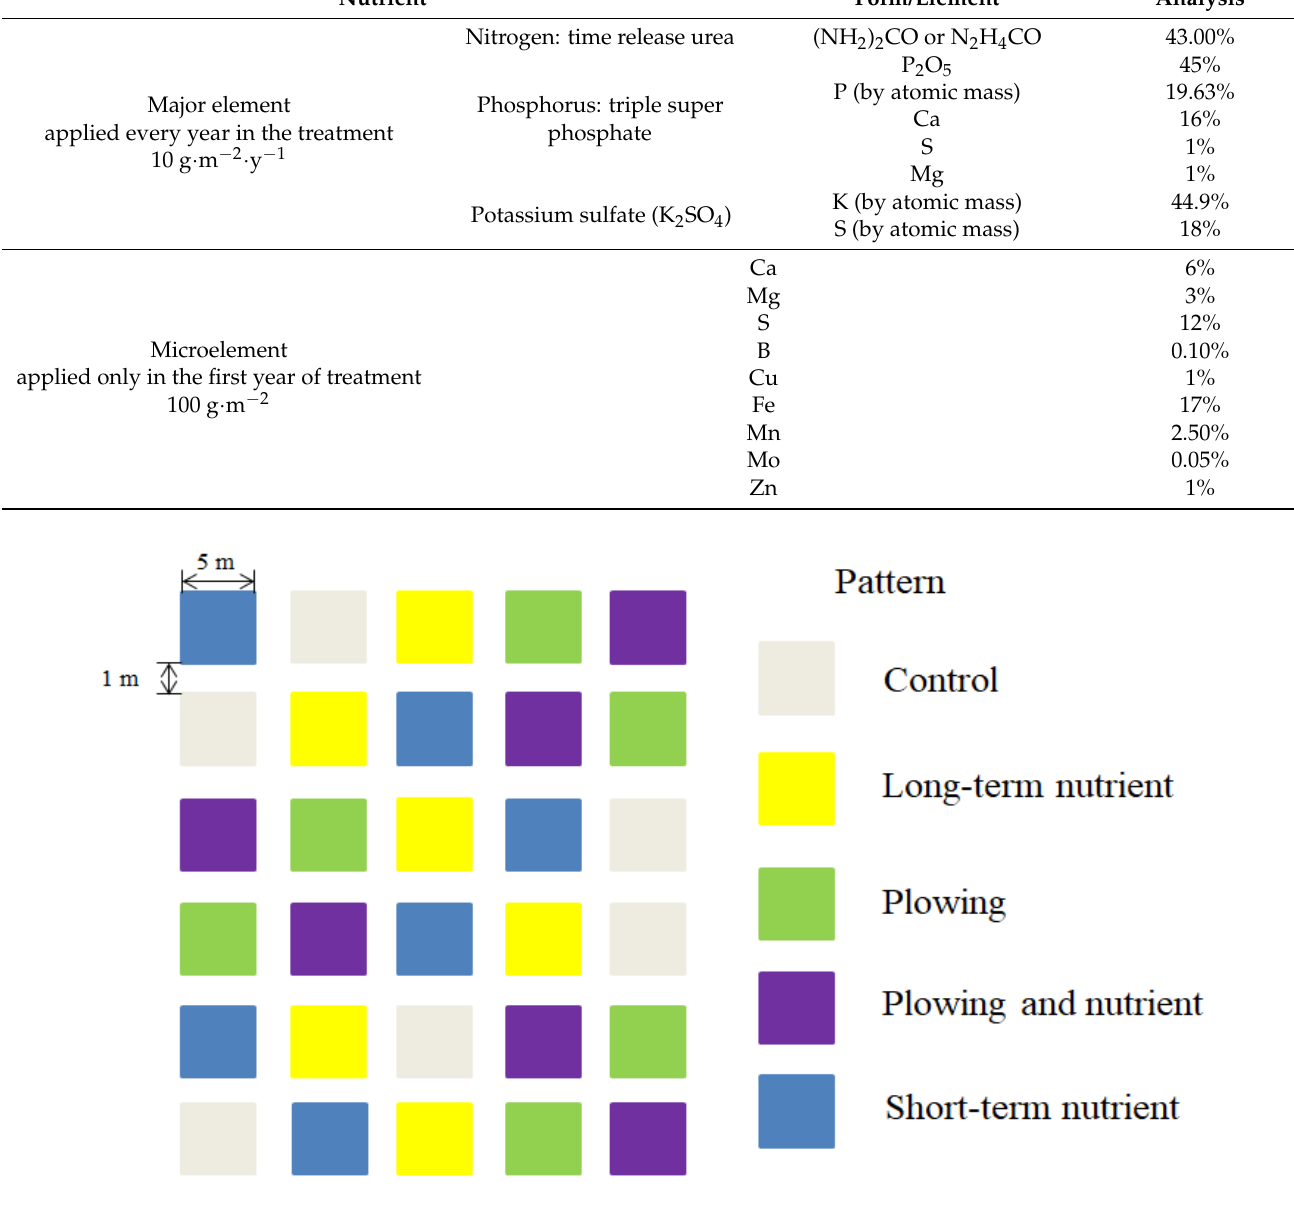
Table 1. Specific formula of the nutrient addition.